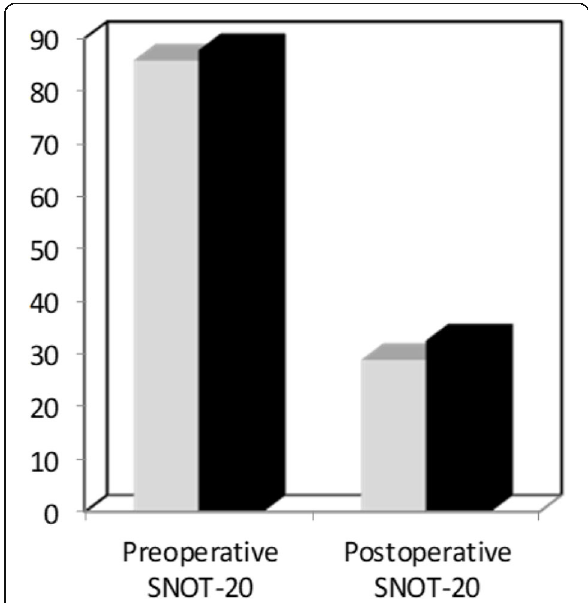
Fig. 3 Bar chart between group A: septoplasty and group B: septoplasty and FESS as regard the SNOT-20